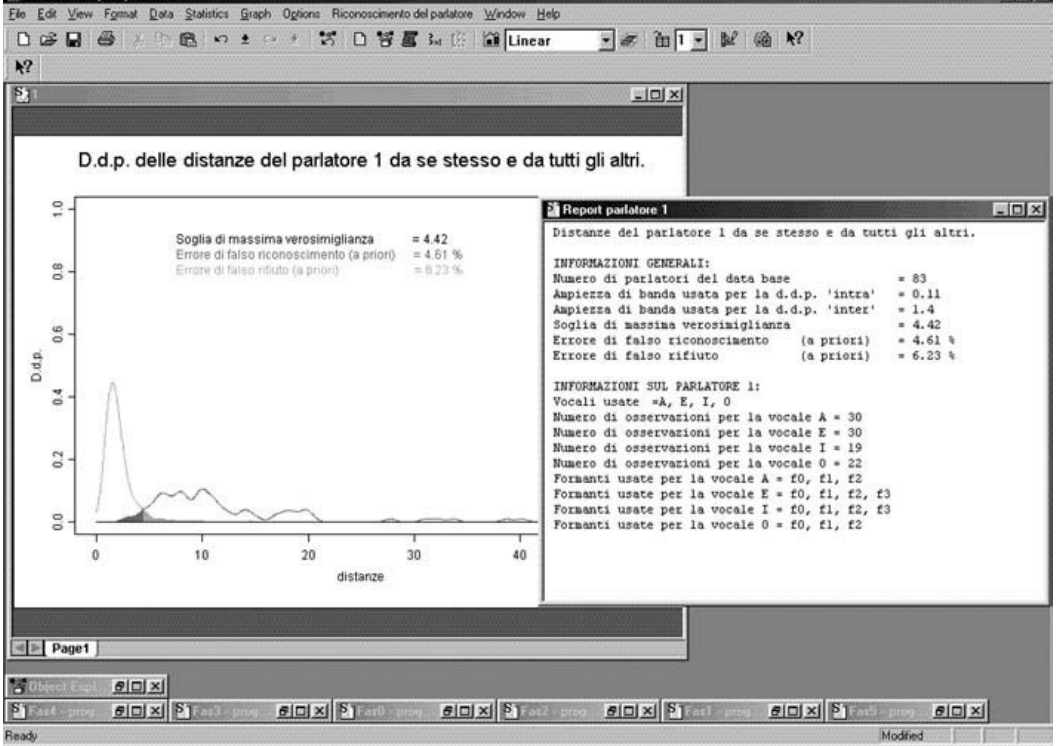
Figura 3 – Finestra relativa alla fase di addestramento: verosimiglianze relative alla distanza